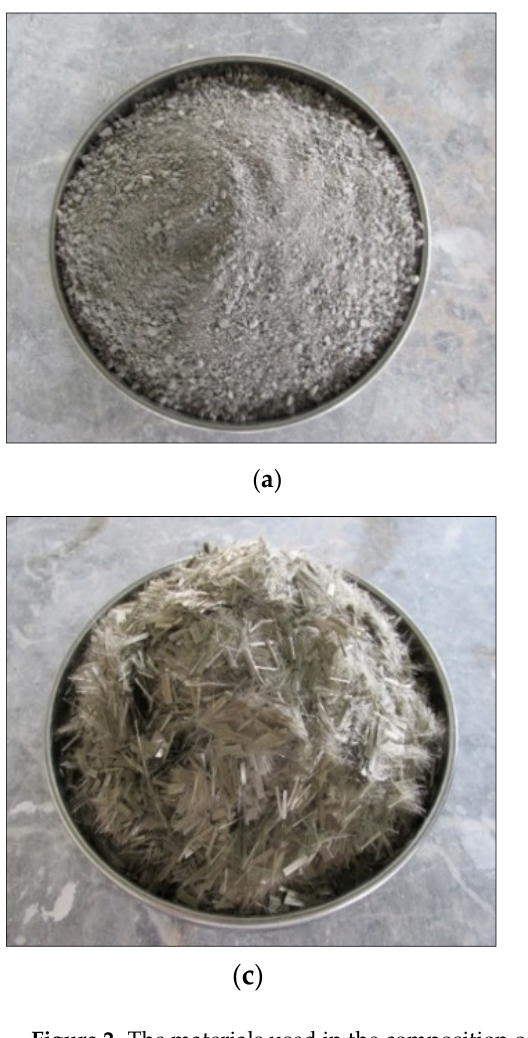
Figure 2. The materials used in the composition of the concrete mixes of the experimental study that includes ( a ) aggregate ( b ) cement ( c ) basalt fibers ( d ) alginate powder